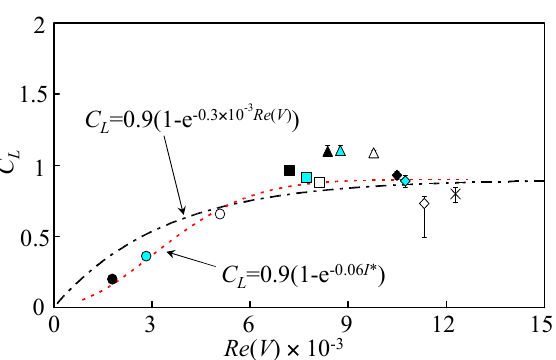
Fig. 17 Lift coefficient C L versus Reynolds number Re ( V ) based on a theoretical descent velocity V , for several values of inertia-moment ratio I * at depth-to-width ratio λ = 0.3, aspect ratio AR = 10, C = 3.86 × 10 2 .